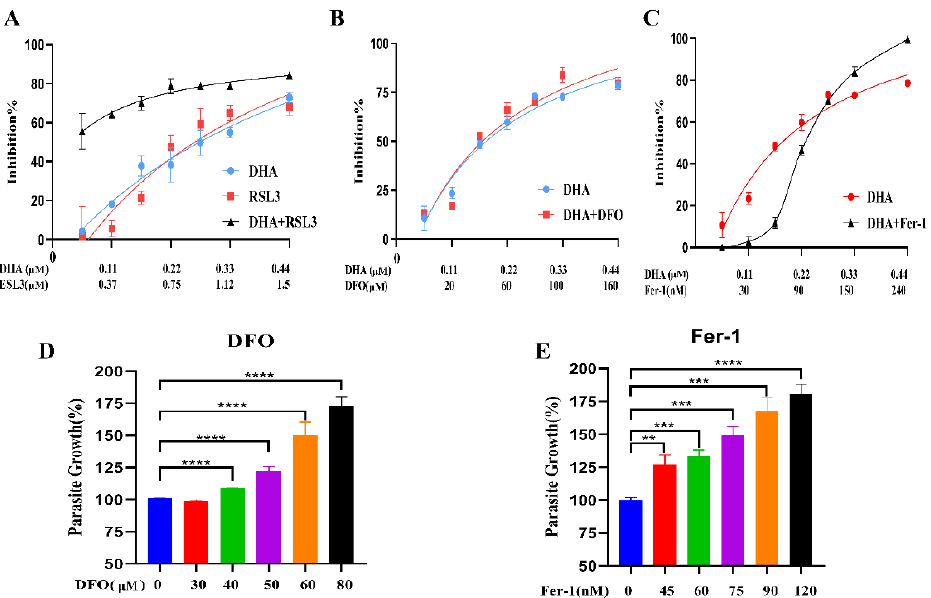
Figure 7. Inhibition of T. gondii growth by a combination of DHA and ferroptosis inducers or inhibitors. ( A ) Dose–effect curves of DHA, RSL3 alone, and DHA + RSL3. ( B ) Dose–effect curves of DHA alone and DHA in combination with DFO. ( C ) Dose–effect curves of DHA alone and DHA in combination with Fer-1. ( D , E ) Parasite growth rates with DFO or Fer-1 at different doses. Statistical analysis used Student’s t -tests (** p < 0.05, *** p < 0.001, and **** p < 0.0001). Each combination was set up in triplicate wells, and the experiments were independently performed at least three